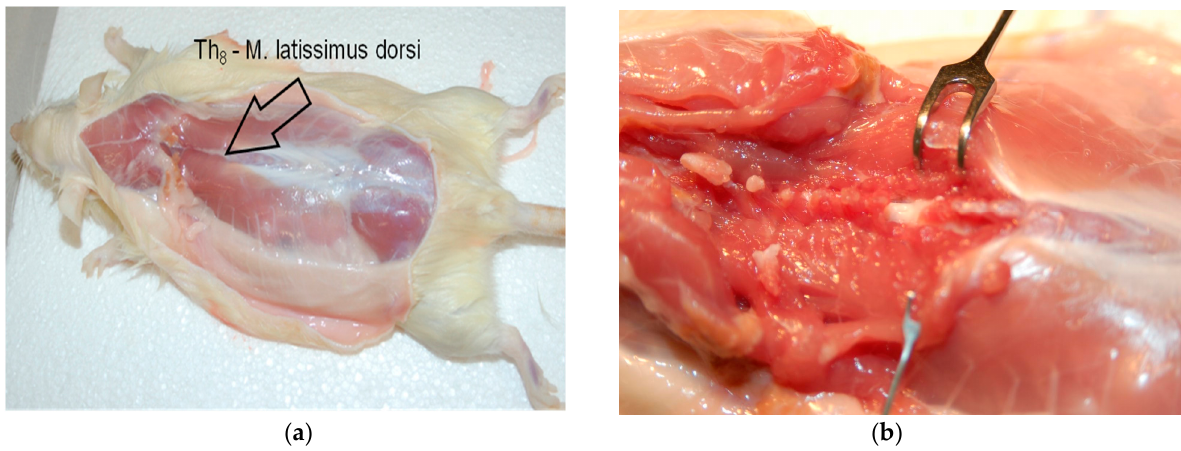
Figure 1. ( a ) The upper margin of the latissimus dorsi muscle (arrow) marks the laminectomy and injury level at Th8; ( b ) the prominent processus spinosus of the second thoracic vertebra was used as a landmark. Laminectomy and injury level at Th8.